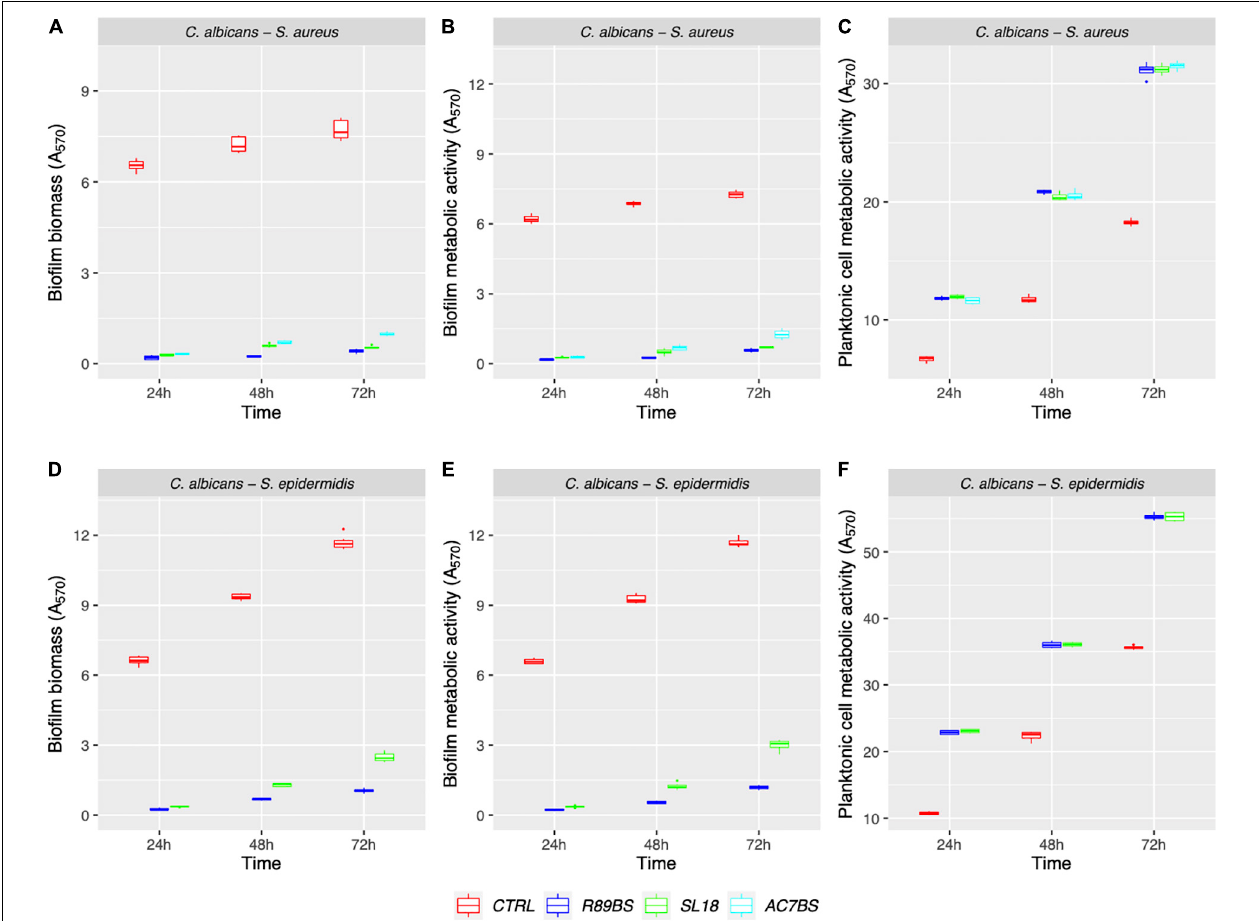
FIGURE 5 | Anti-biofilm activity of the BSs coated silicone discs. The efficacy of the surface treatments was evaluated in terms of biofilm biomass (A,D) and biofilm metabolic activity (B,E) . The viability of planktonic cells was measured by the metabolic activity assay (C,F)